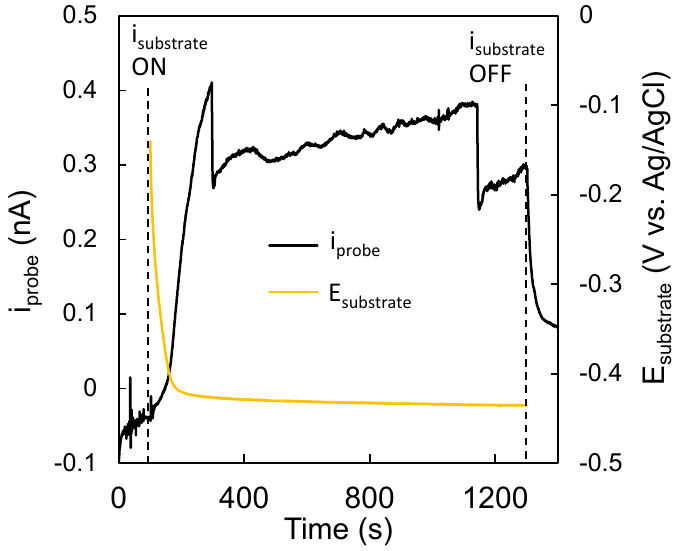
Figure 10. Trends of substrate potential and probe current over time. Obtained in 0.5 M H 2 SO 4 . Substrate, 5-min-WO 3 /MoS x ; tip, 25 µm diameter Pt microelectrode.